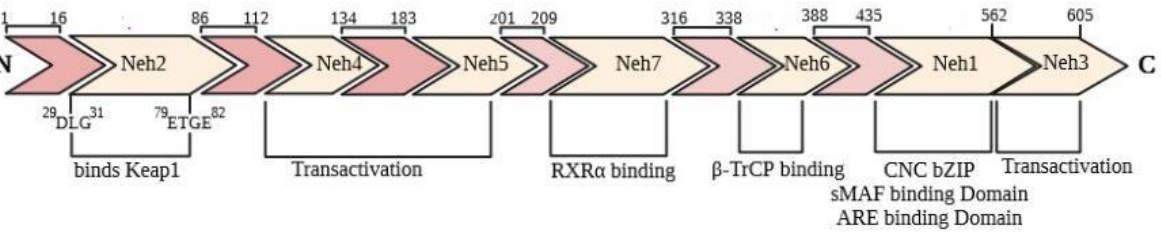
Figure 1. Domain structure of Nrf2. The seven functional domains (Neh1–7) and their positions.